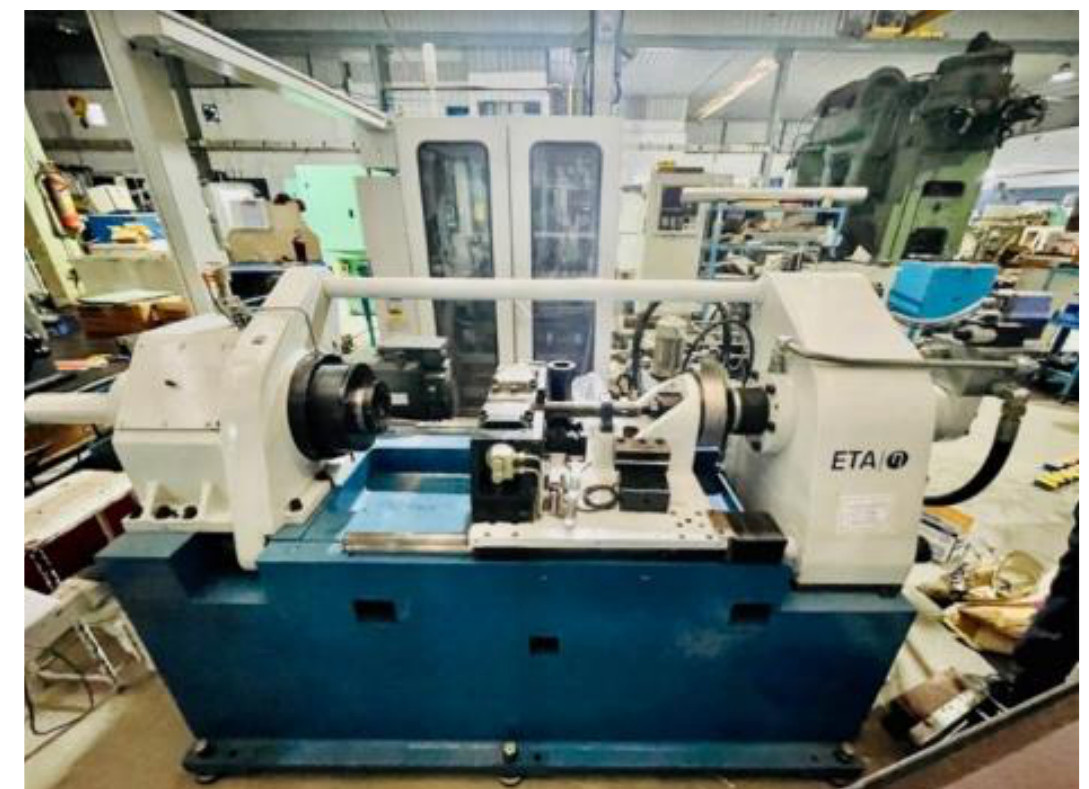
Figure 1. Rotary friction welding setup. Table 3. Parameter employed for